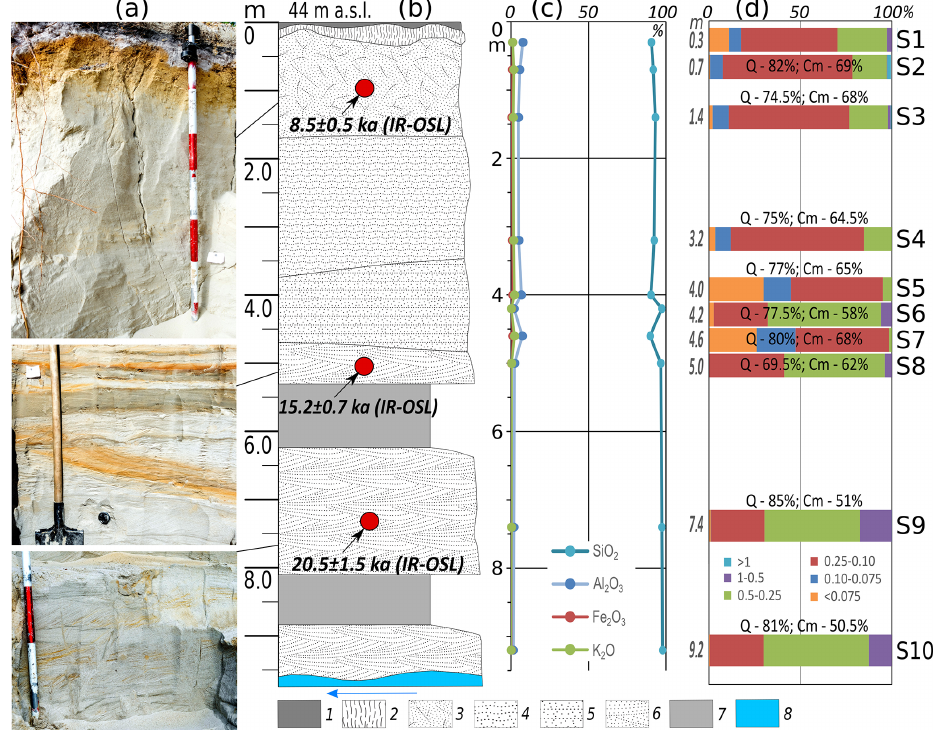
Figure 3. Summary results of research for section NS-6. (a) Photographs (by Sizov in 2017); (b) geological structure and the dating results (see Table 3); (c) bulk chemical data; (d) grain size distribution (fractions,mm). Symbols: (1) podzol horizon of modern soil; (2) illuvial-iron (spodic) horizon of modern soil; (3) sands without stratification; (4) undulating sand with secondary ferruginisation; (5) horizontally layered sand with stratification of loam; (6) medium- and coarse-grained oblique sand; (7) colluvium; (8) river level; Q : coefficient of roundness of the sand quartz grains; Cm: degree of dullness; S: sample